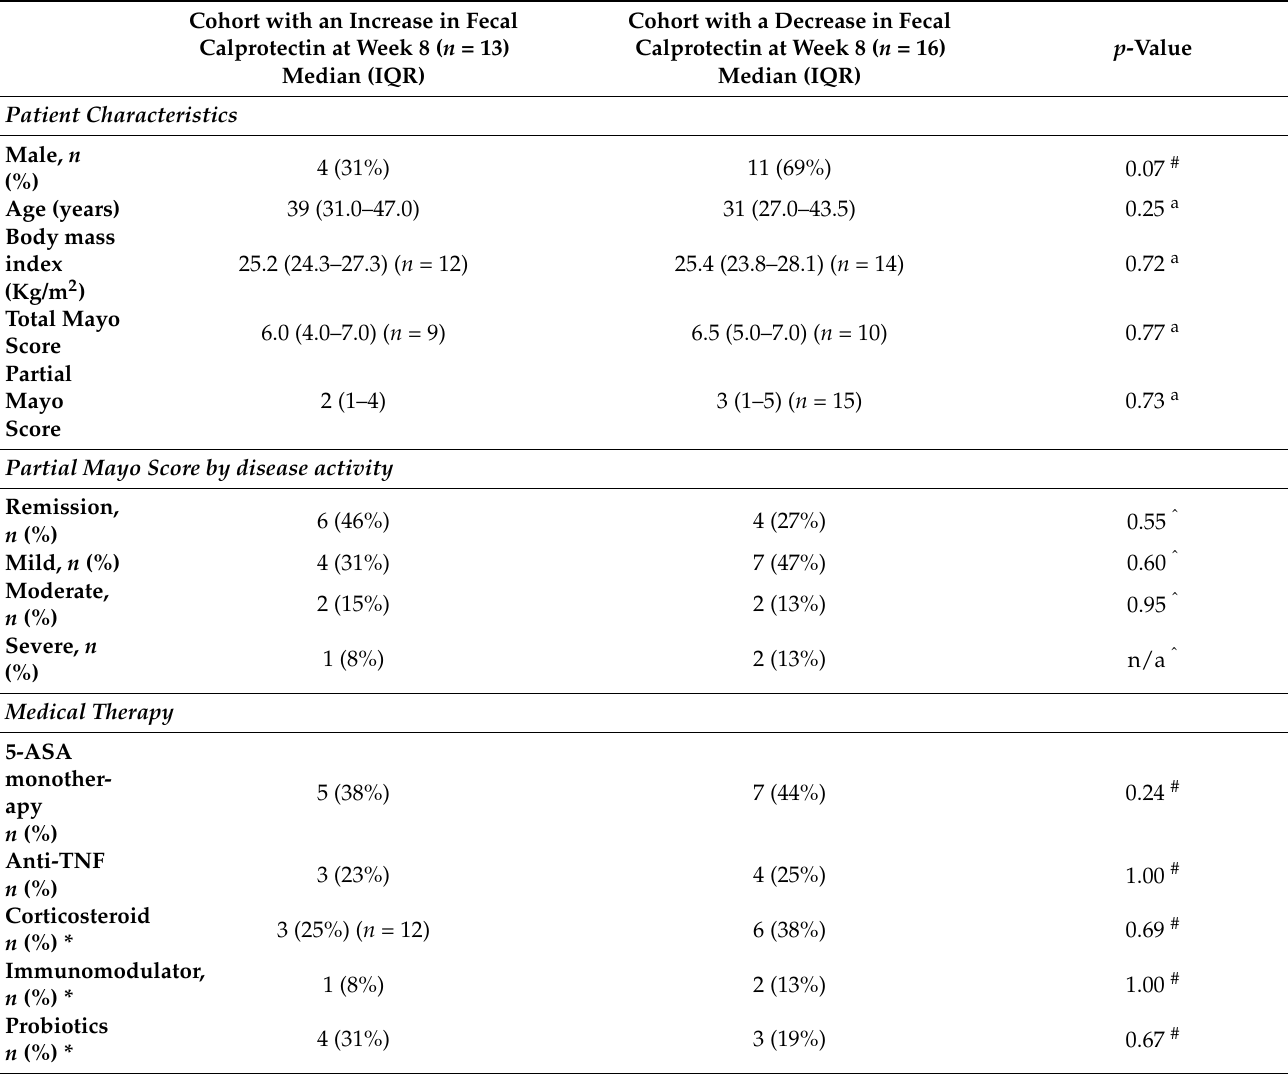
Table 1. Characteristics of the study participants with changes in fecal calprotectin from baseline to week 8 ( n =